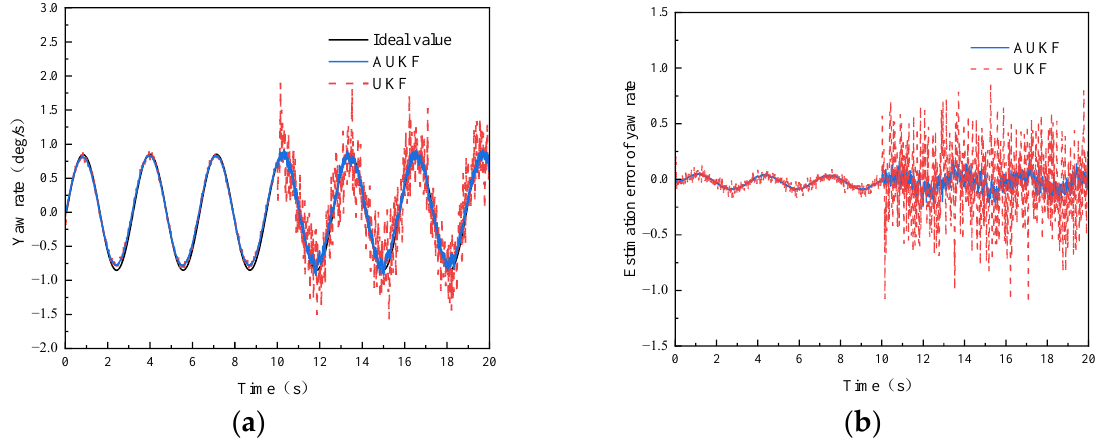
Figure 9. Simulation results of yaw rate. ( a ) Comparison of estimated results and ( b ) comparison of estimated error.